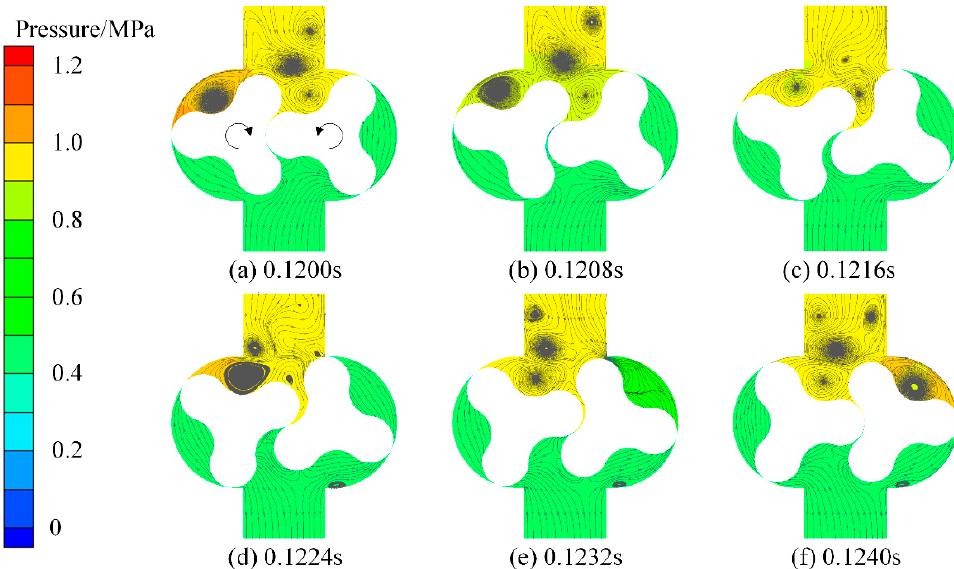
Figure 11. Pressure streamline contours of the Roots pump when the inlet CO 2 volume fraction is 1. Flow time: ( a ) 0.1200 s; ( b ) 0.1208 s; ( c ) 0.1216 s; ( d ) 0.1224 s; ( e ) 0.1232 s; ( f ) 0.1240 s.